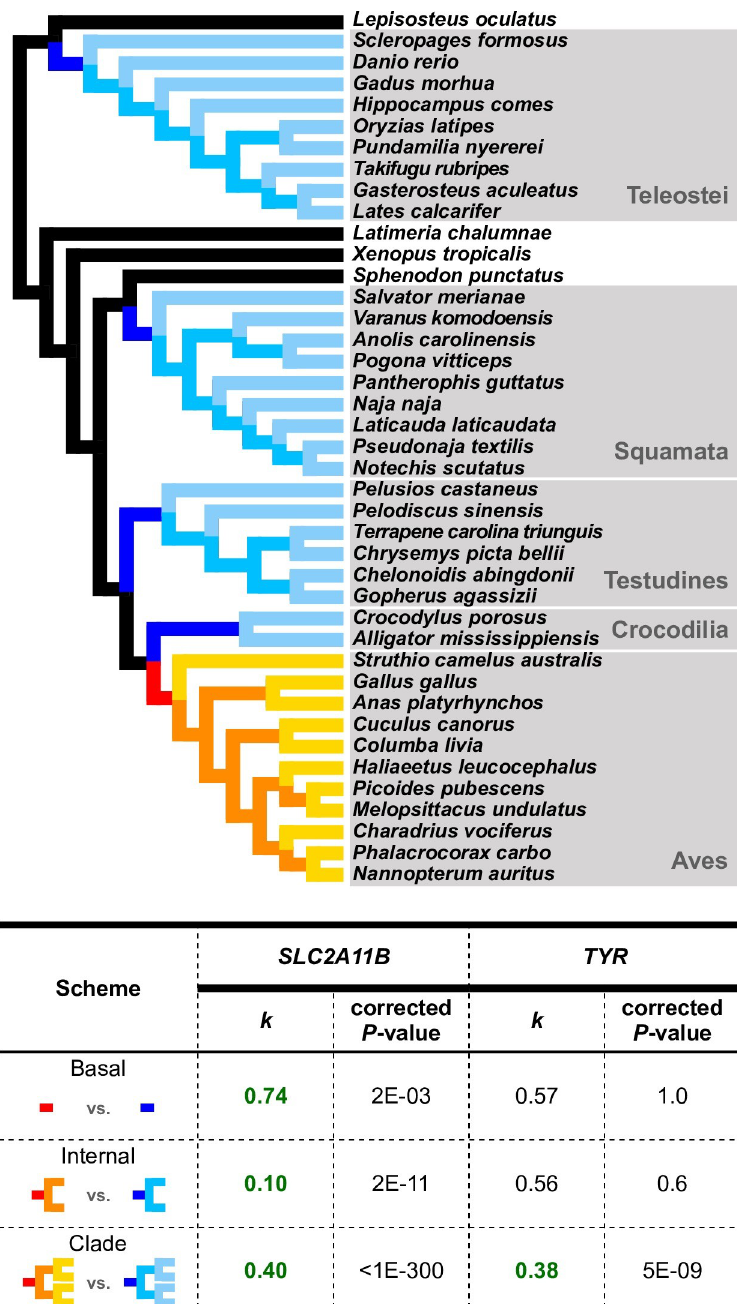
Fig 7. RELAX tests indicate consistent relaxation of selection in avian SLC2A11B but not TYR . Three different schemes of test/reference branch designations were illustrated by color-labeled branches (red/dark blue for “basal”, red and orange/dark and intermediate blue for “internal”, all warm colors/all cool colors for “clade”) in the phylogeny and were tested separately (see Materials and Methods). The results with birds (warm-colored branches) as test branches are shown in the table below (see S6 Table for more results). The k values significantly smaller than 1, which indicate relaxation of selection, are highlighted in bold green font. The P -values shown are after Bonferroni correction for multiple